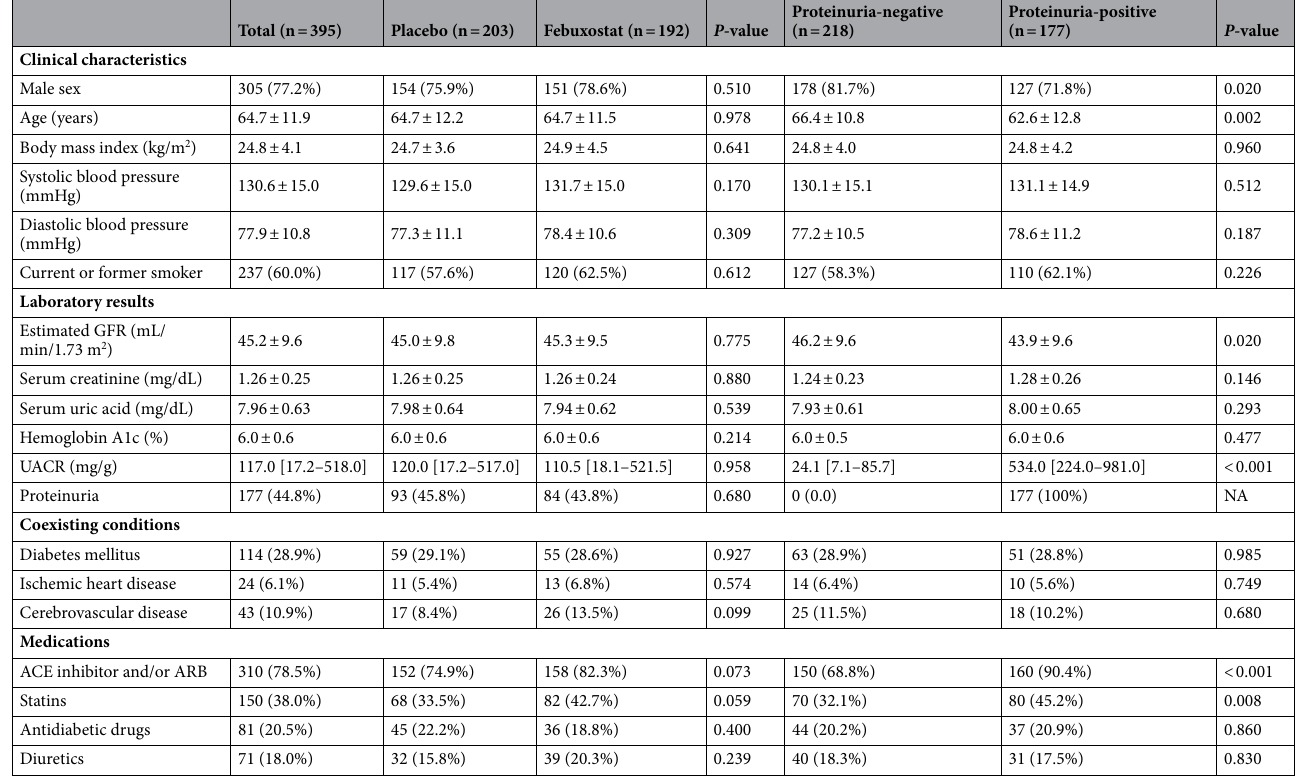
Table 1. Baseline characteristics of the study participants according to febuxostat treatment and presence or absence of proteinuria. Values for categorical variables are given as count (percentage); values for